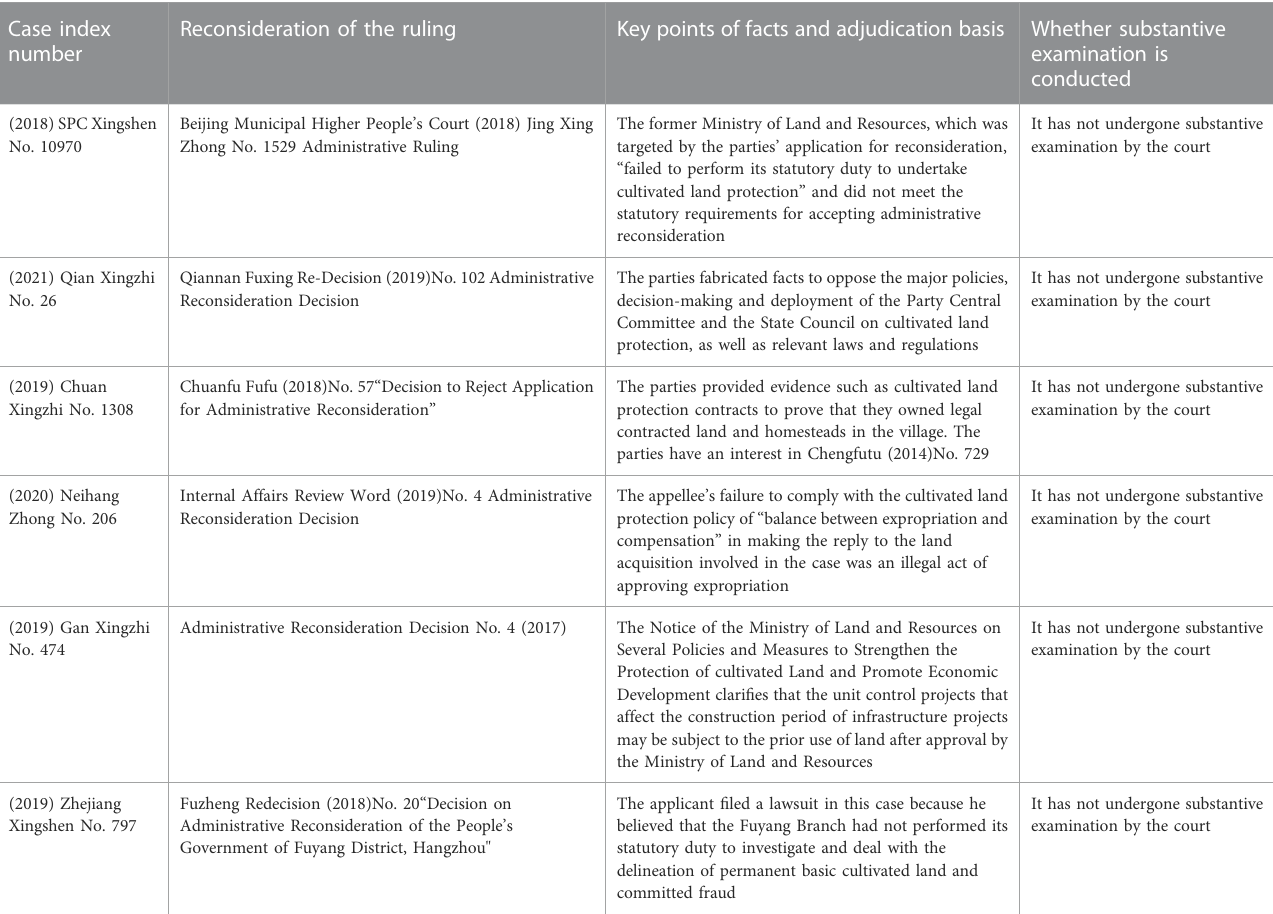
TABLE 2 Idle phenomenon of administrative reconsideration of cultivated land